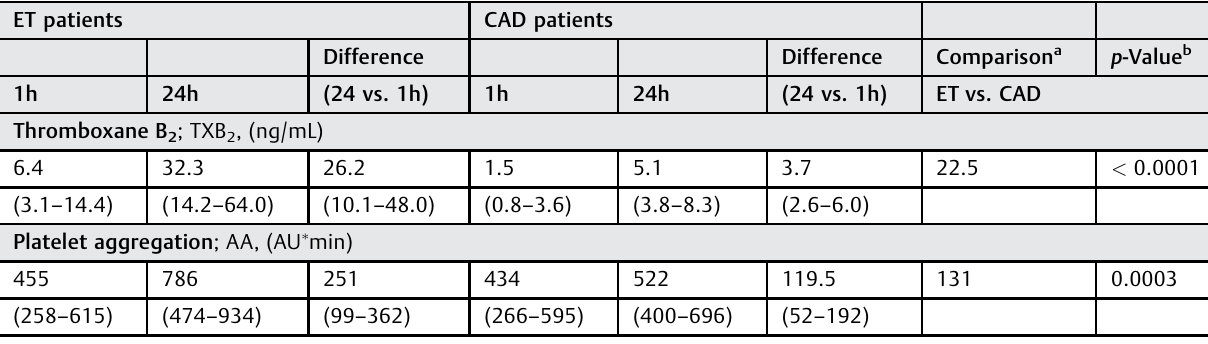
Table 2 Platelet function, re fl ecting the antiplatelet effect of aspirin, analyzed by platelet aggregation and serum thromboxane B 2 measurements ( n ¼ 48 in both patient groups) ET